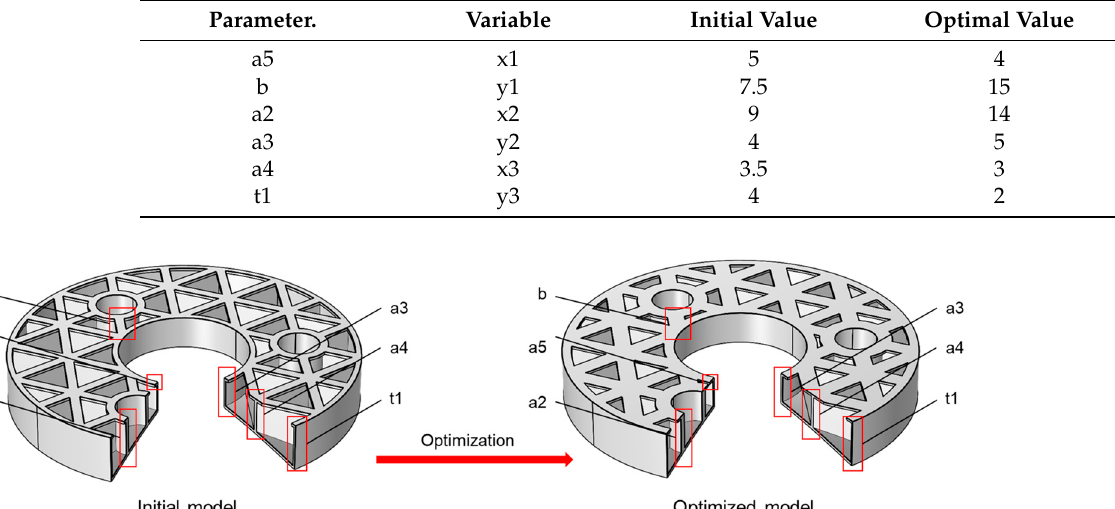
Table 5. Comparison of parameters between the initial and improved structures (Unit: mm).